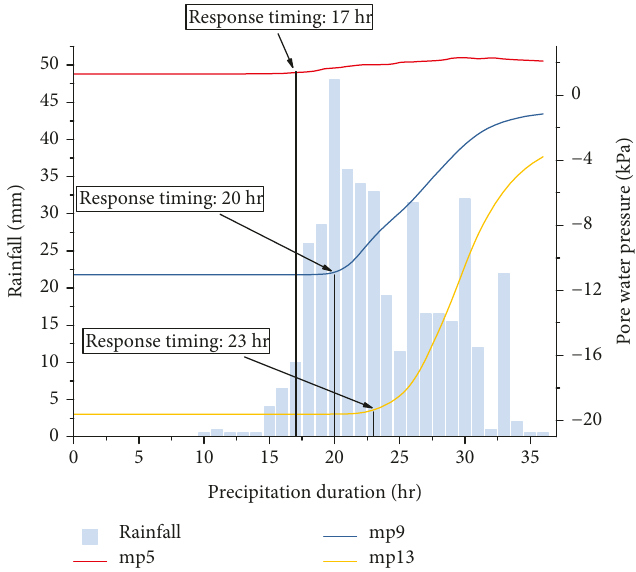
Figure 12: The variation of the pore water pressure for monitoring points: mp5, 9, and 13.